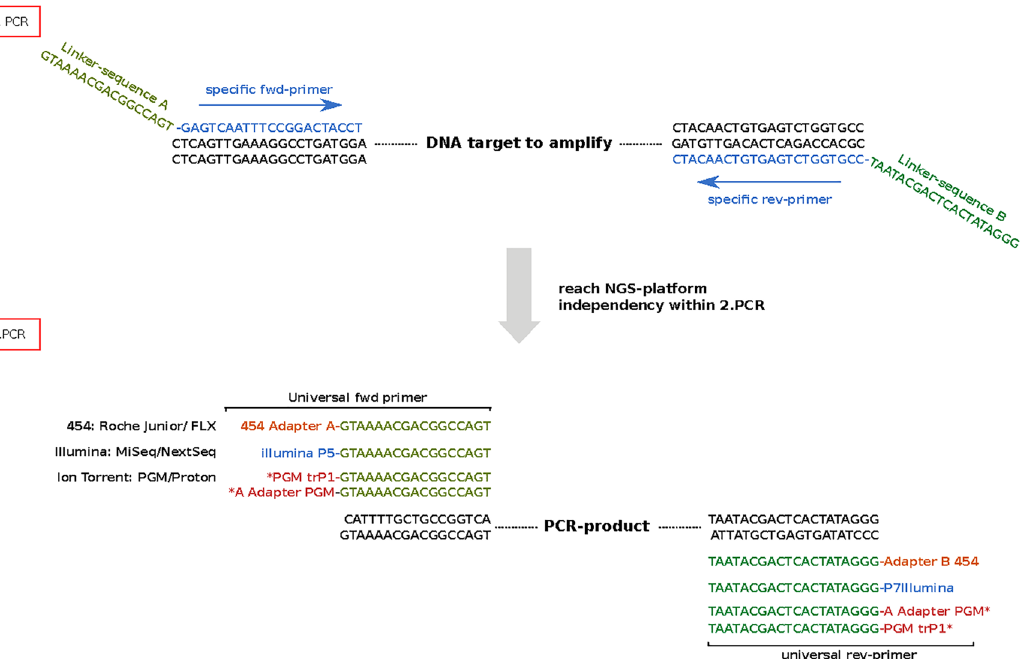
Fig 1. Universal two-step PCR approach. First-round PCR is performed by using gene-specific primers tailed with a universal linker sequence (light and dark green). The universal tailed amplicons can be used for second-round PCR, where deep sequencing platform-specific adapters can be introduced for either PGM (dark red), Illumina (blue), or 454 (orange). * To prepare PGM amplicon libraries containing trP1 and A adapter sequences on both ends of the library the second-round PCR has to be separated in two reactions with different primer combinations, respectively. All platform-specific amplicon libraries can be prepared with unique barcodes to sequence multiple